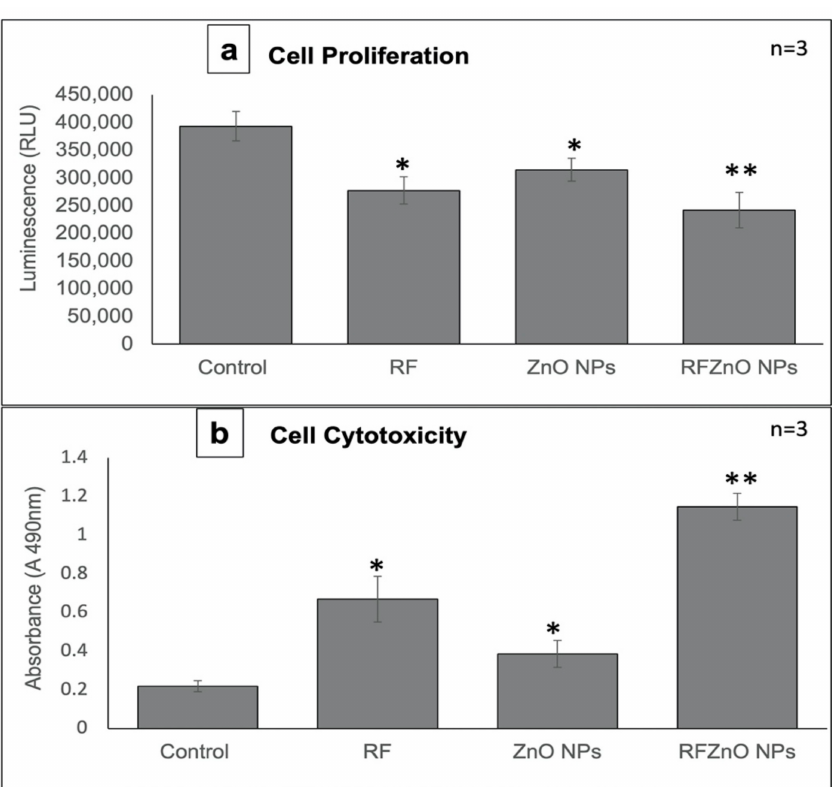
Figure 2. ( a ) Measurement of cell proliferation by adenosine triphosphate (ATP) luminescent assay. Control cells showed maximum levels of ATP. ATP levels were significantly decreased in cells treated with Rubus fairholmianus (RF 10 µ g/mL), zinc oxide nanoparticles (ZnO NPs 10 µ g/mL), and R. fairholmianus capped zinc oxide nanoparticles (RFZnO NPs 10 µ g/mL). ( b ) Lactate dehydrogenase (LDH) was used to measure cytotoxicity. A significant increase in cytotoxicity 24 h after treatment with RF, ZnO NPs, and RFZnO NPs was observed. Significant differences are shown as * p < 0.05 and ** p < 0.01. Results represent the mean ± SE of three independent